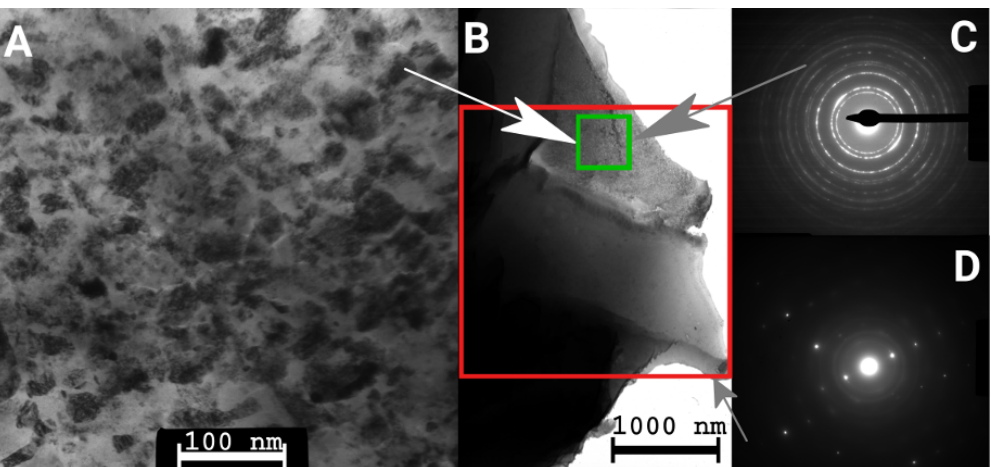
Figure 7. TEM images and selected-area electron diffraction (SAED) patterns for sample SAA1000. ( A ) TEM image of a fine-grained area at large magnification. ( B ) TEM image at lower magnification showing the coexistence of coarse-grained and fine-grained parts in the microstructure. The TEM image in ( A ) was taken within the area of the small green square. ( C ) The SAED pattern obtained from the fine-grained area shown ( A ), where only fcc diffraction rings are observable. ( D ) SAED pattern obtained from a larger area within the large red square in ( B ) which reveals both diffraction rings from fine-grained areas and diffraction spots from individual large grain(s). The arrows indicate the areas where the diffraction patterns and the high magnification image were taken.